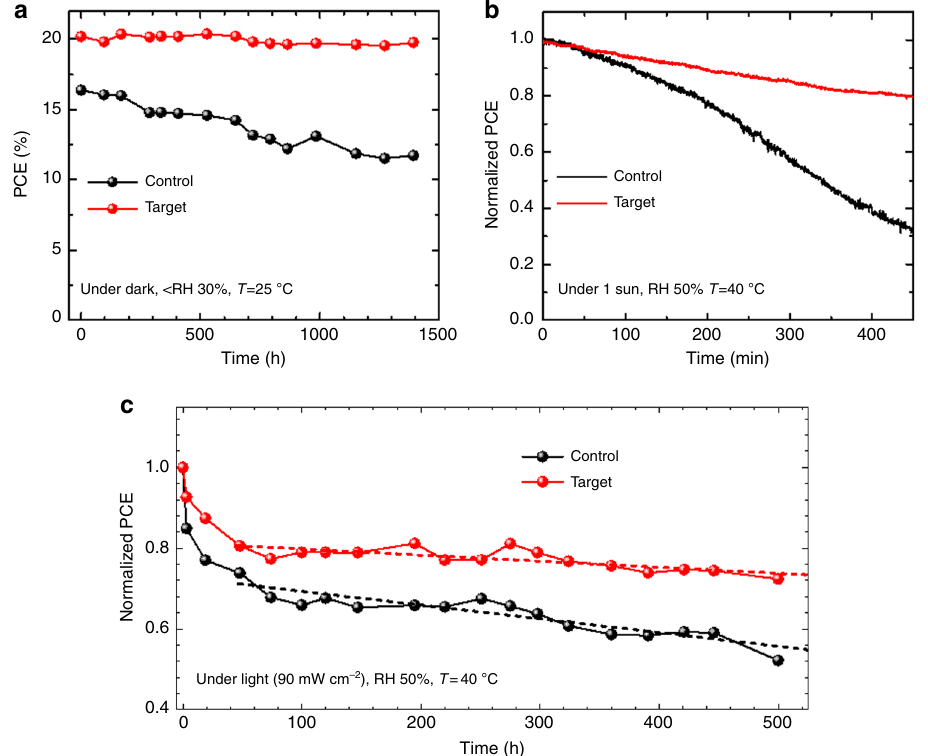
Fig. 5 Improved stability with 2D perovskite. a Evolution of power conversion ef fi ciency (PCE) of control and target devices. The devices were stored under dark with controlled humidity. b Maximum power point tracking of the devices under 1 sun illumination in ambient condition without encapsulation. c Evolution of the PCEs measured from the encapsulated control and target devices exposed to continuous light (90 ± 5 mW cm − 2 ) under open-circuit condition. The stabilized PCEs were measured at each time. Initial stabilized PCEs for control and target devices were 14.5% and 17.5%, respectively. The broken lines are linear fi t of the post-burn-in region (after 48 h). Relative humidity (RH) and temperature ( T ) are indicated in the graphs for